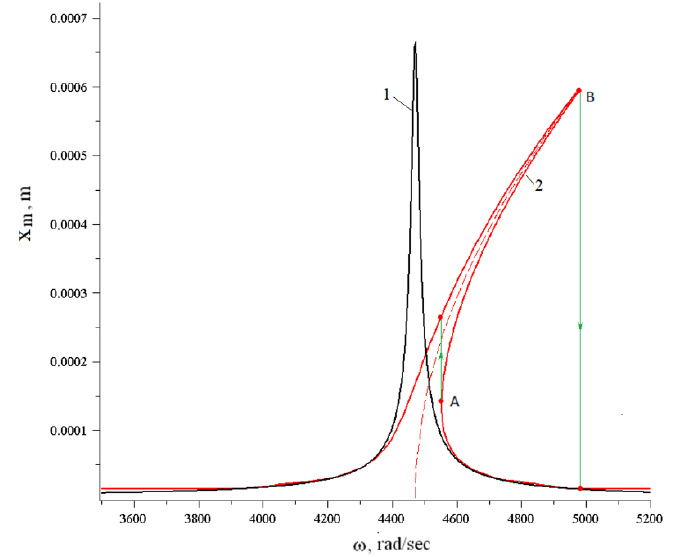
Figure 2. Hydroelastic response of the channel wall: 1: linear support spring: black line ( n 3 = 0), 2: spring with strong cubic nonlinearity: red line ( n 3 > 0); the dotted line shows the skeletal curve ω ; A and B—frequencies at which the amplitudes of nonlinear oscillations can change abruptly; green lines with arrows—directions of amplitude change.